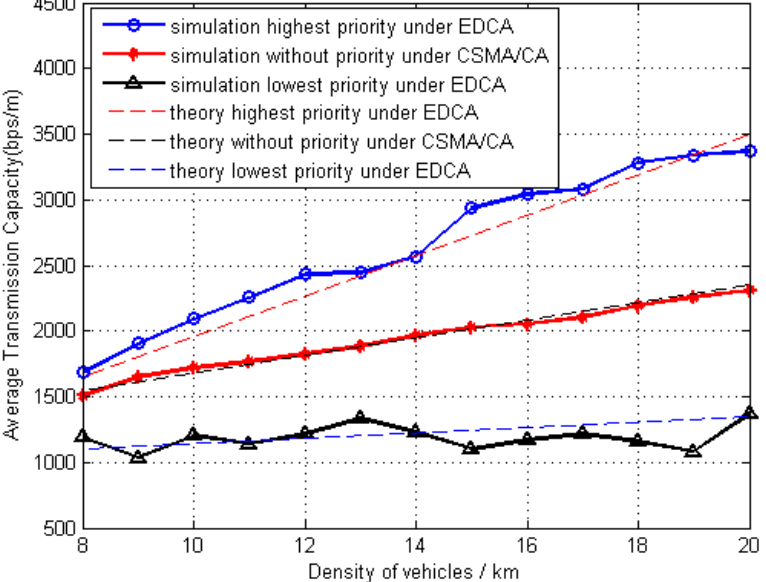
Figure 6. Transmission capacity with different priorities versus the density of the active transmitters.